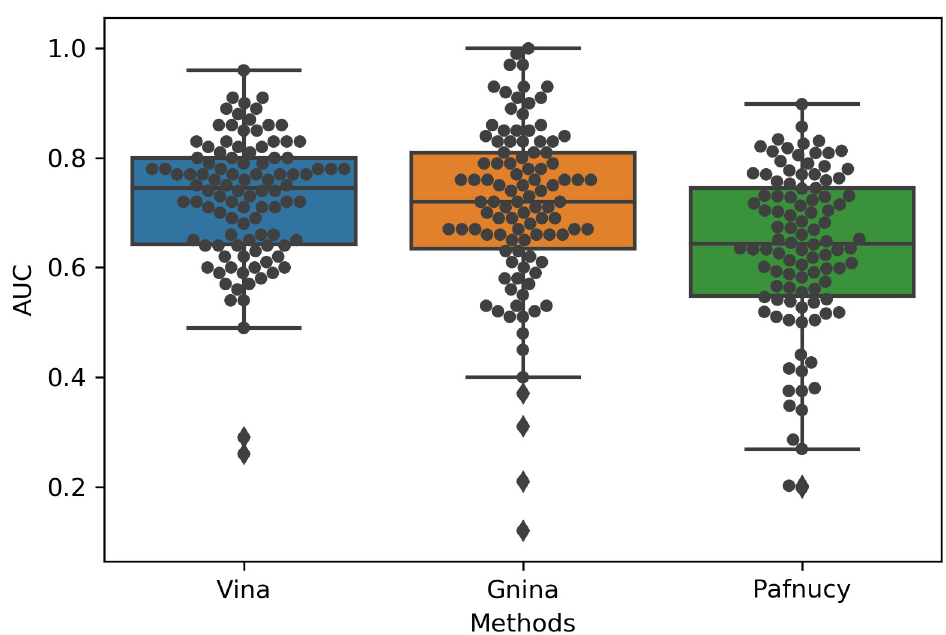
Fig 13. The AUC value distribution for Vina, Gnina and Pafnucy performed on all 102 DUD-E targets. Each black dot represents a DUD-E target.